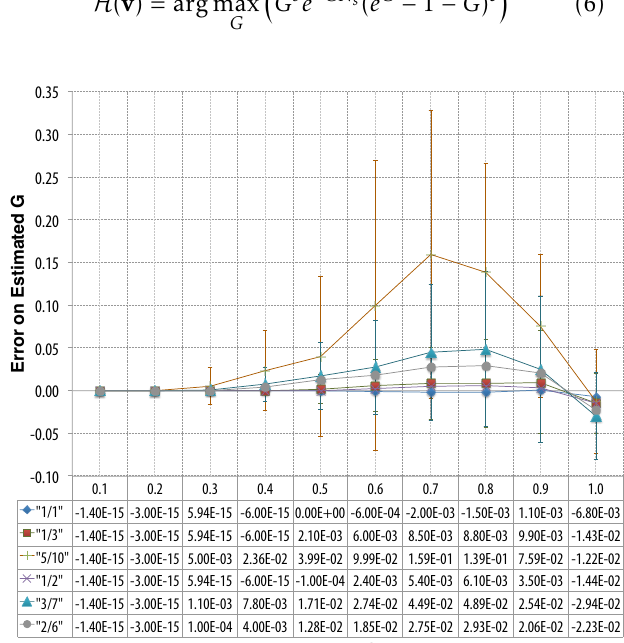
Figure 1. Error on load estimation ( N techniques combined with the use of linear codes in transmission.